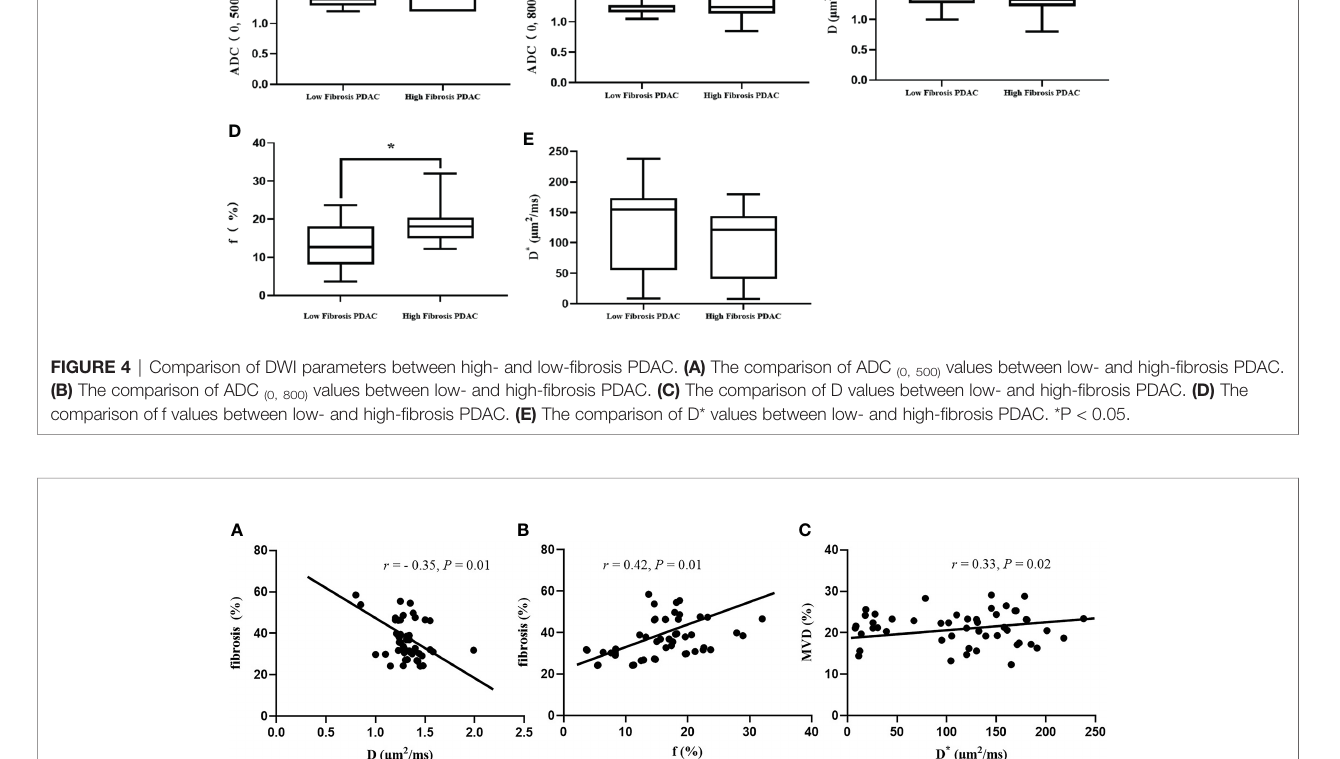
FIGURE 5 | Correlation between DWI parameters and histopathology features. (A) Correlation between D values and fi brosis. (B) Correlation between f values and fi brosis. (C) Correlation between D* and MVD.